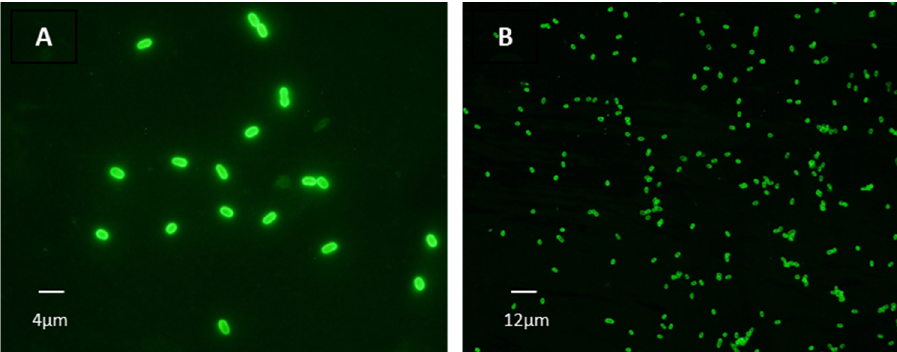
Figure 2. Distribution of anti- E. cuniculi serum titers by IFAT.